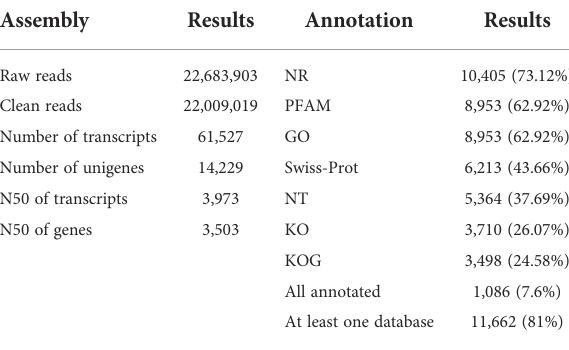
TABLE 1 The de novo transcriptome assembly and annotation of C.